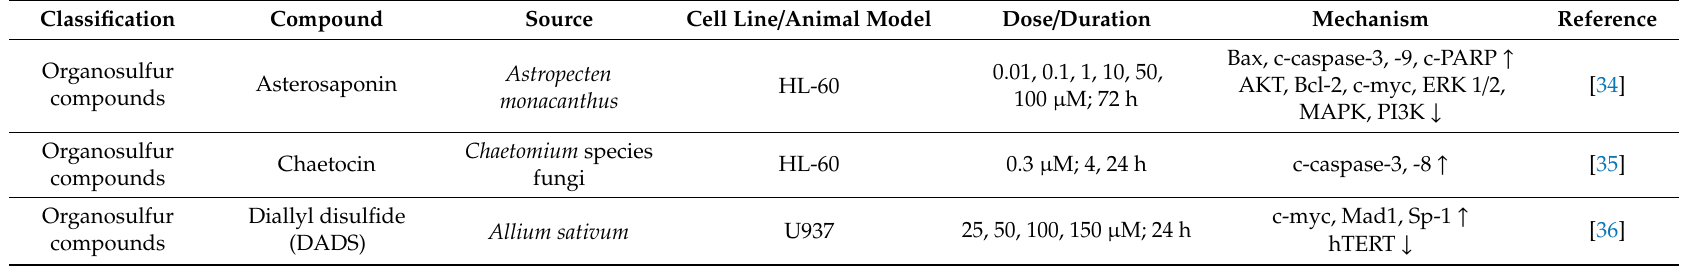
Table 4. Organosulfur